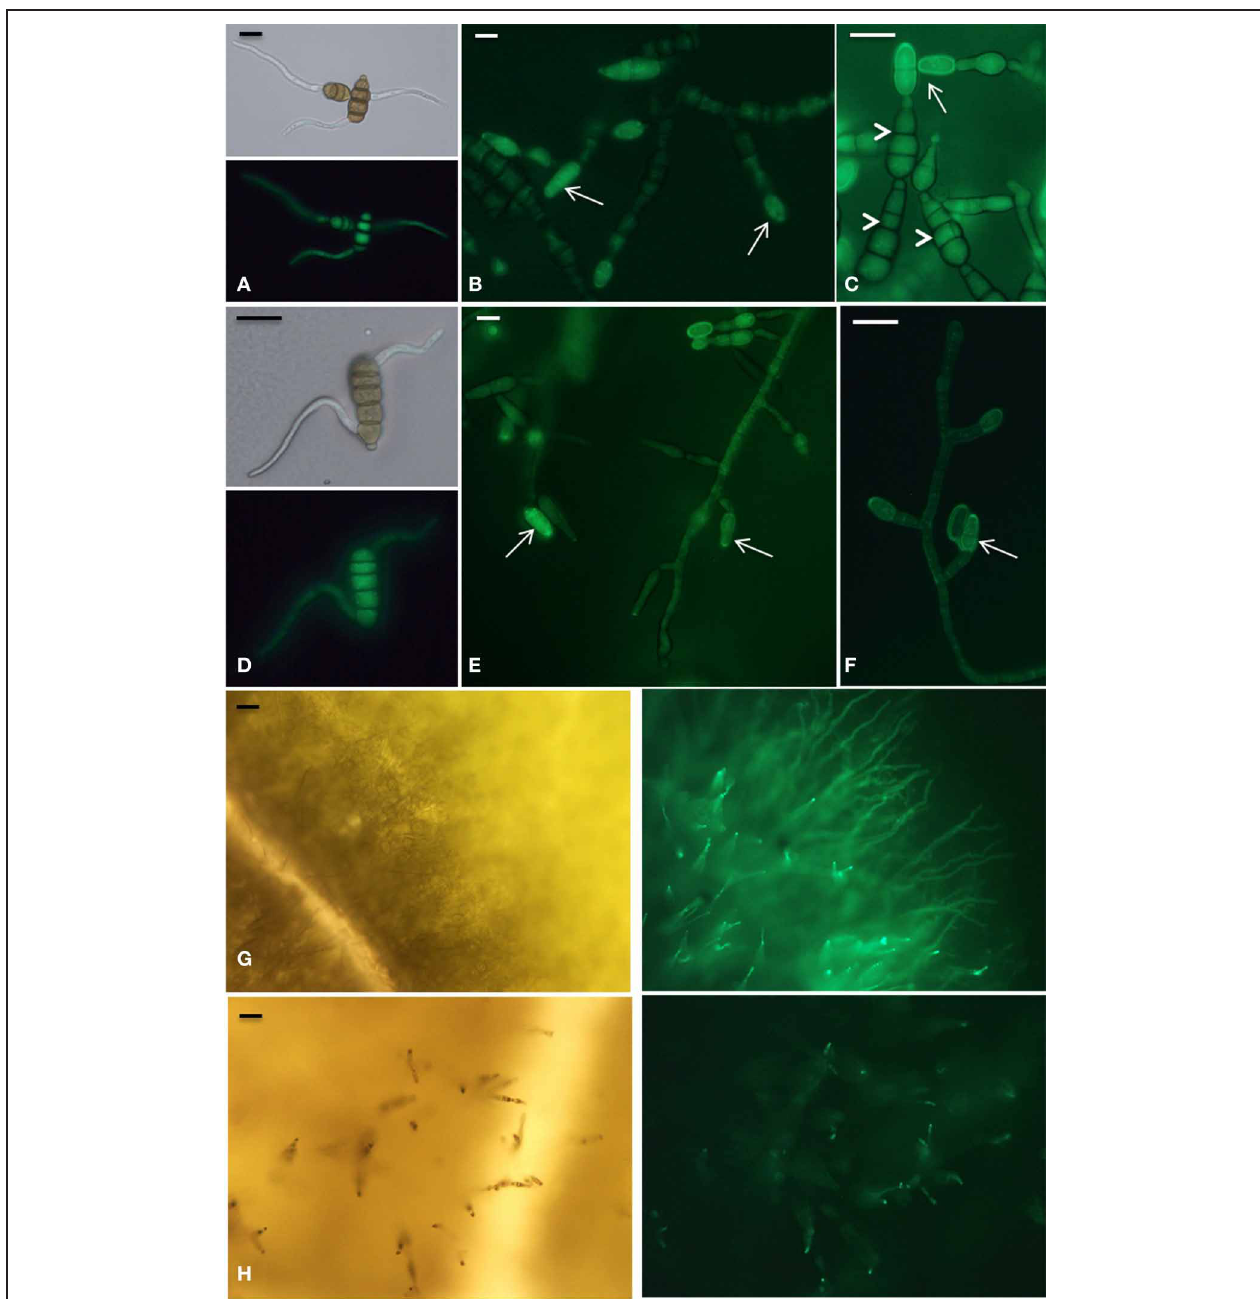
stage, hyphae started to differentiate into conidiophores, leading to the production of young (arrow) and mature (arrowhead) conidia. Scale bars = 10 μ m. (G) and (H) Fungal growth 6 days after inoculation of B. oleracea leaves. At this time, the fluorescence signal increased in aerial hyphae during the conidiation process. The right part corresponds to fluorescence microscopy and the left part to bright-field microscopy. Scale bars = 30 μ